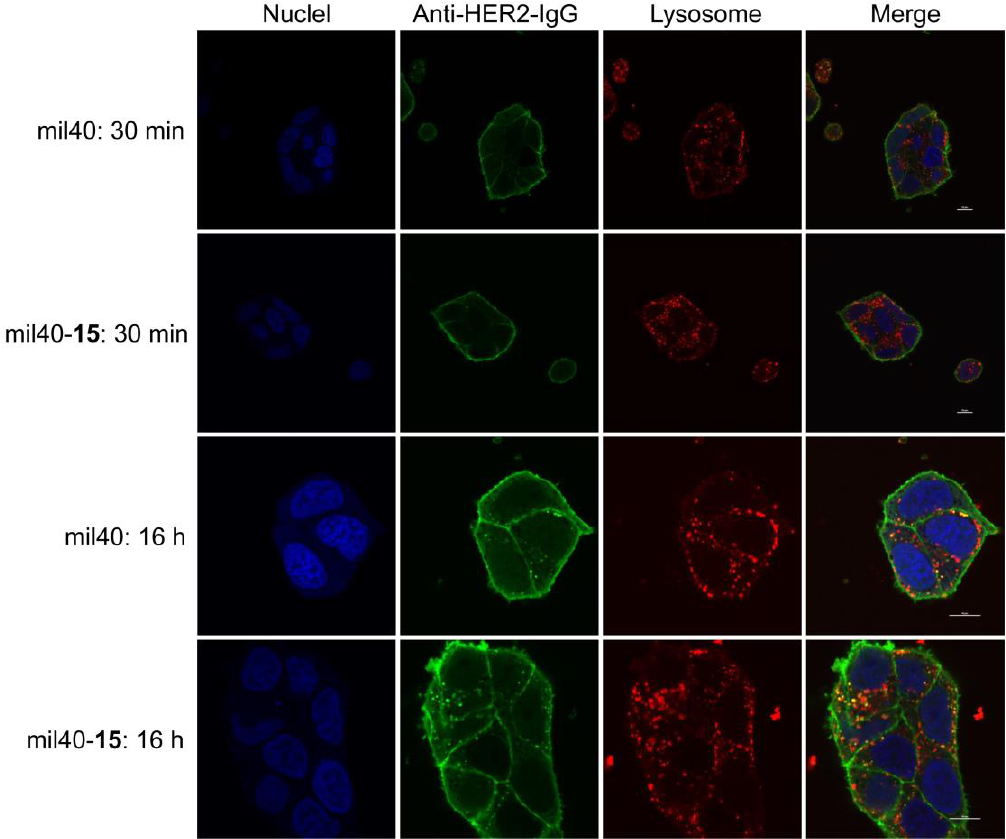
Figure 5. Receptor-mediated internalization of the Cys-linker-MMAE-based ADC in the HER2 + breast cancer cell line BT-474. Cells were treated at 4 °C with mil40 and mil40- 15 labeled with an Alexa Fluor 488-conjugated goat anti-human IgG antibody for 0.5 h and further incubated at 37 °C for 16 h. Scale bar = 10 μm.